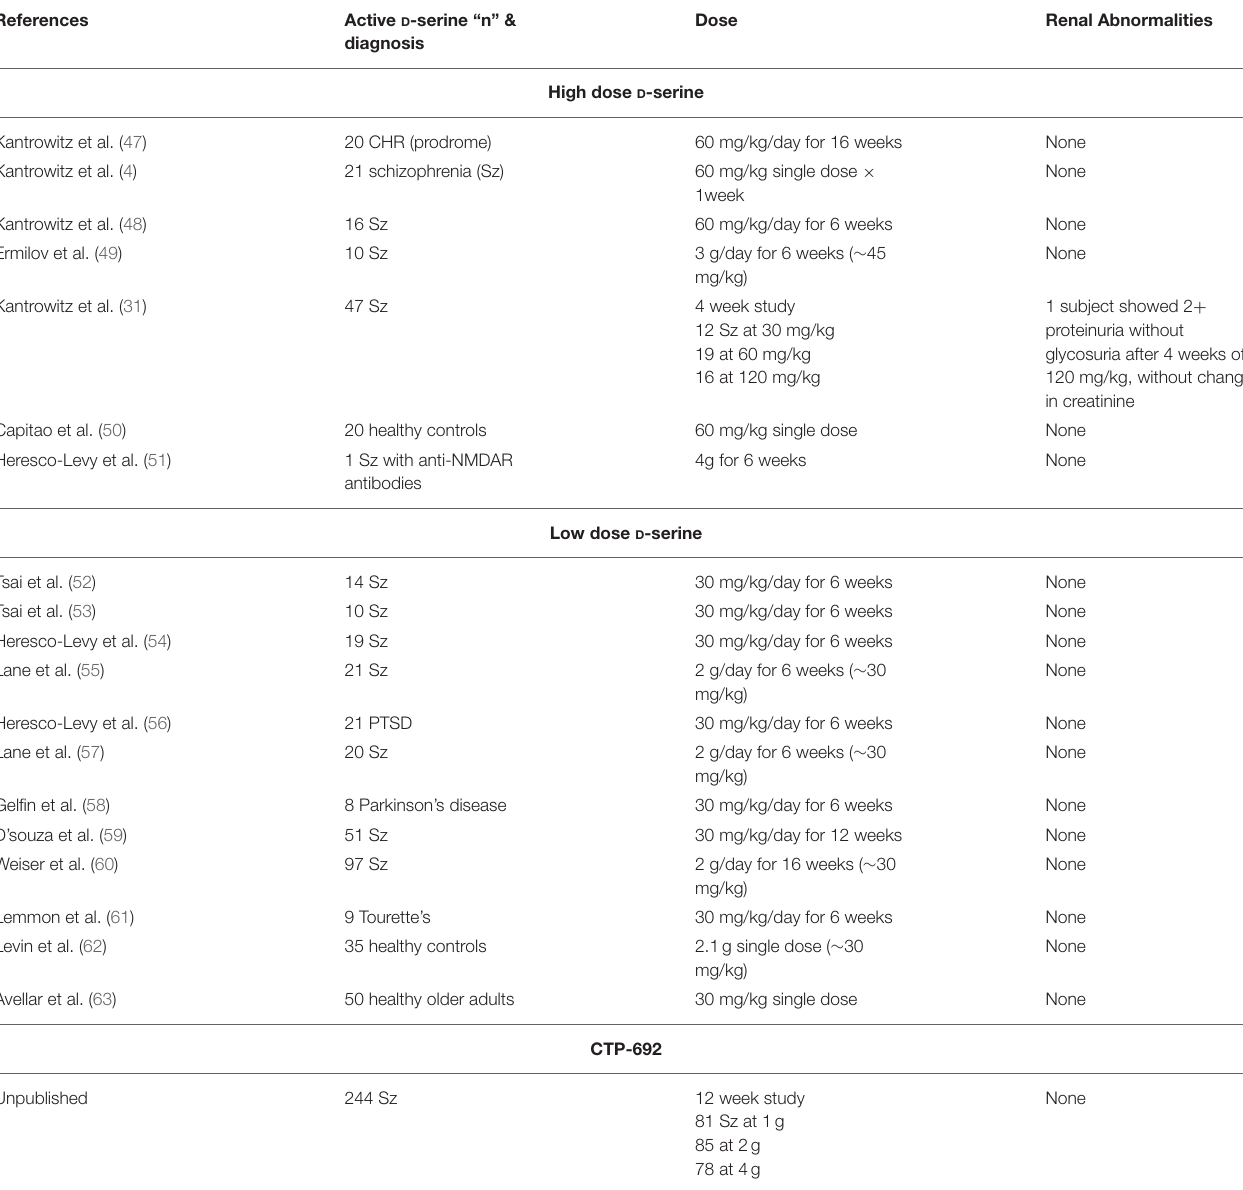
TABLE 1 | Renal safety of D